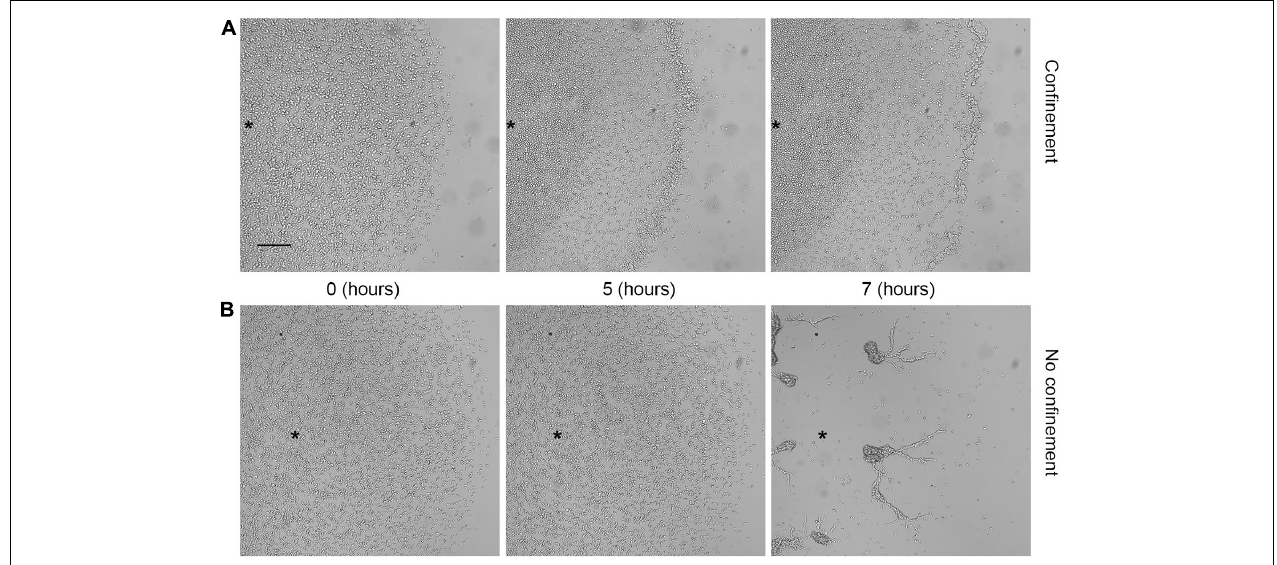
FIGURE 4 | Aerotactic migration occurred independently from cell proliferation. Dictyostelium starving cells under (A) confinement or (B) no confinement conditions. Photograms taken at different times (0, 1, and 5 h) using Zeiss Axiovert 200 microscope, with a magnification of 5 × . Scale bar = 200 µ m. Asterisks indicate approximately the center of the cell cluster.